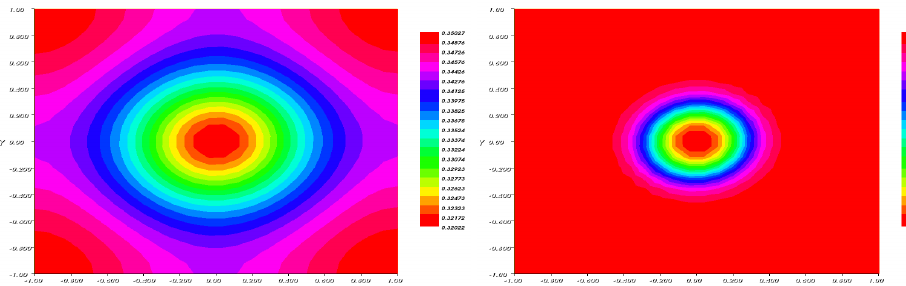
Figure 11. The fraction ϕ ( left ) and ψ ( right ) after T = 15.